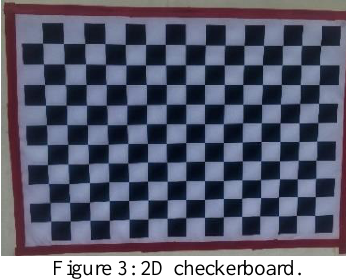
Figure 3: 2D checkerboard.